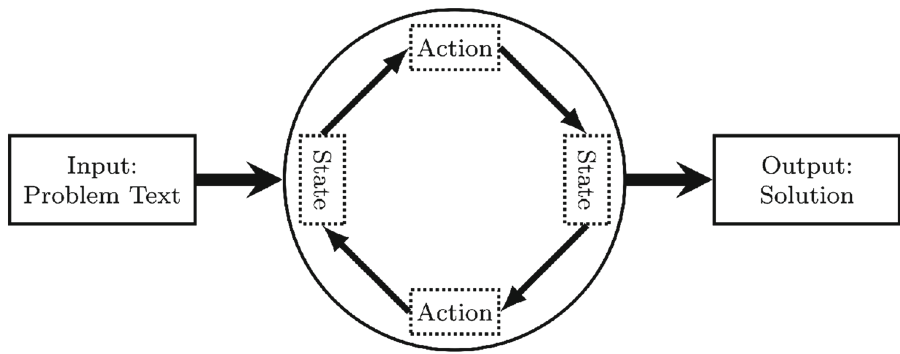
Fig. 2 The state-action paradigm of solving